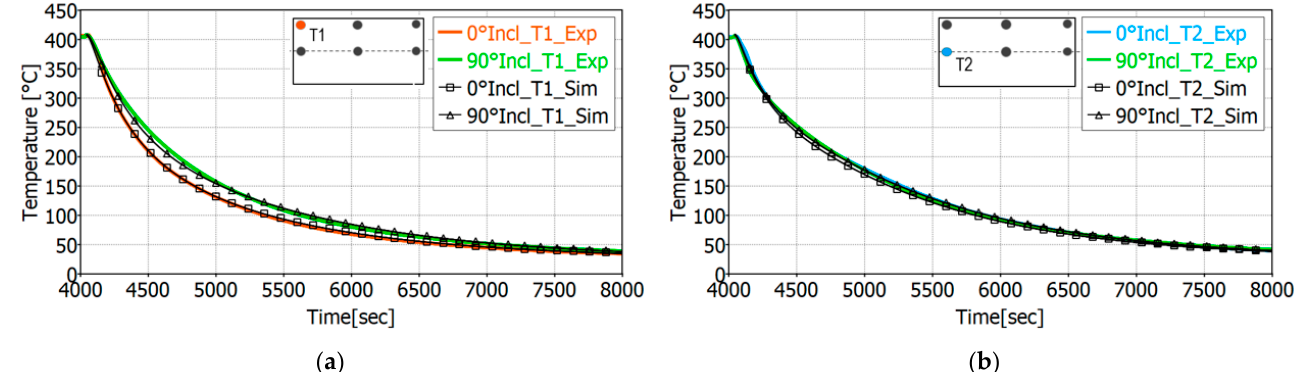
Catalysts 2021 , 11 , x FOR PEER REVIEW Figure 9. Effect of inclination on the temperature profile of the monolith face ( a ) close to the periphery and ( b ) in the center.